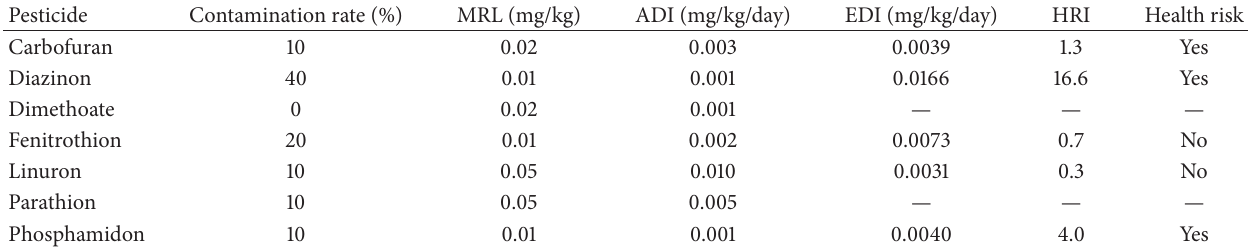
Table 3: Percentage contamination and HRIs of the investigated pesticides for